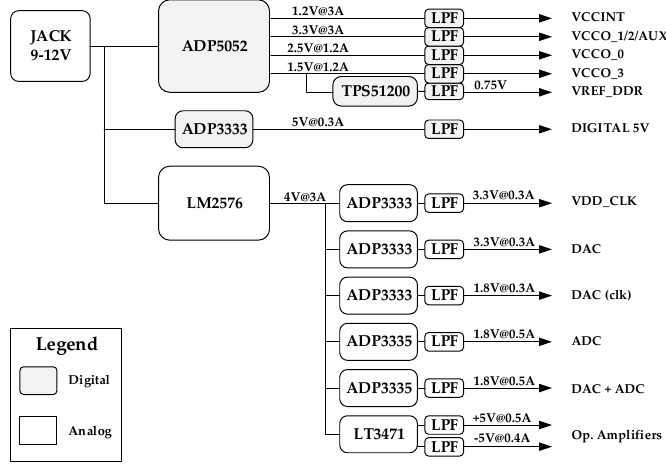
Figure 3. Power supply distribution of the IRIS platform where analog and digital separated sources can be